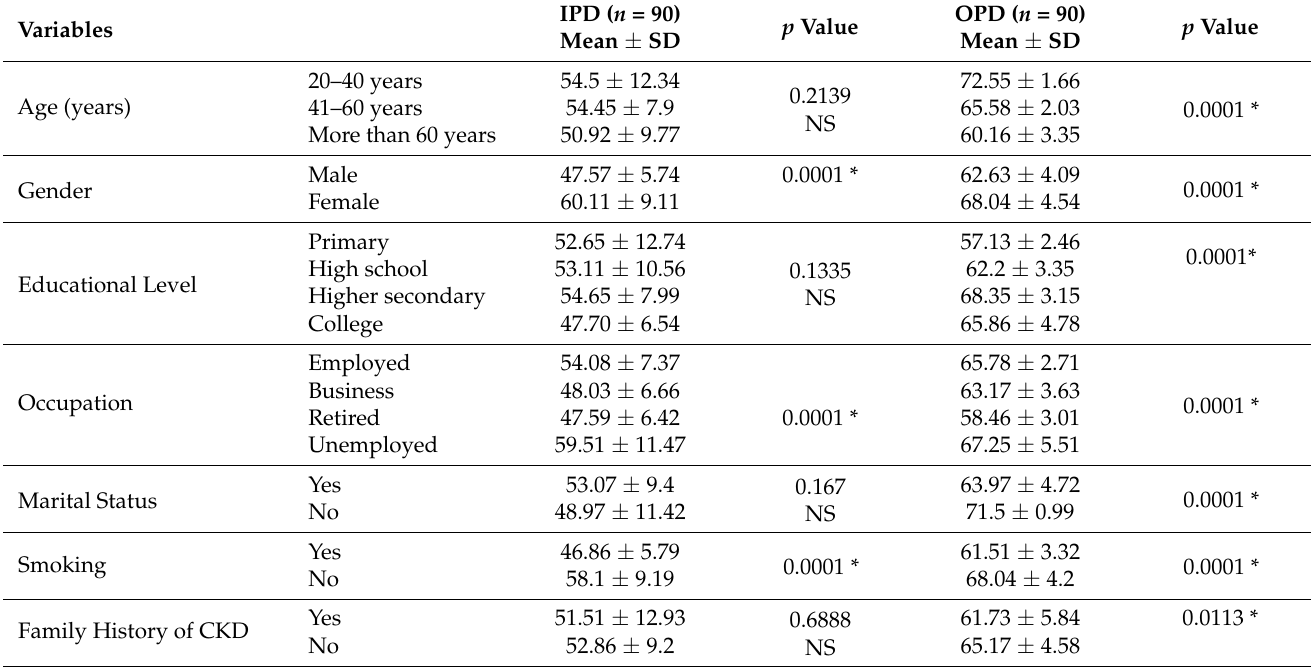
Table 5. Association of demographic variables with KDQOL-SF summary scores of the